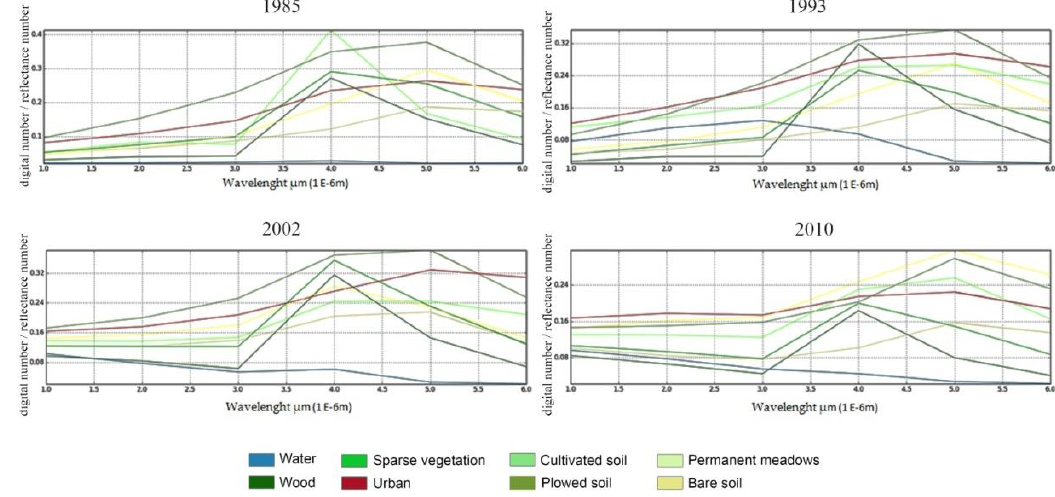
Figure 5. Trend of the spectral signatures of the samples of each cover soil class for the four investigated dates.